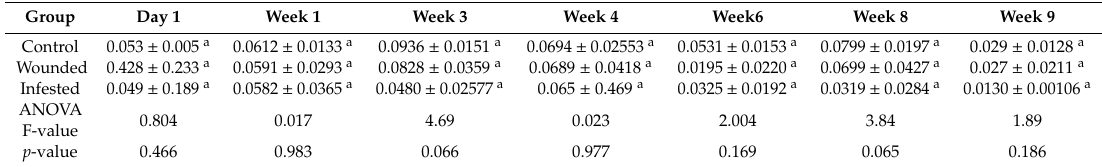
Table 3. Mean ± SD and results of one-way ANOVA of stomatal conductance at each time post-infestation. Di ff erent letters indicate significant di ff erences based on ANOVA following Tukey multiple comparison test ( p >